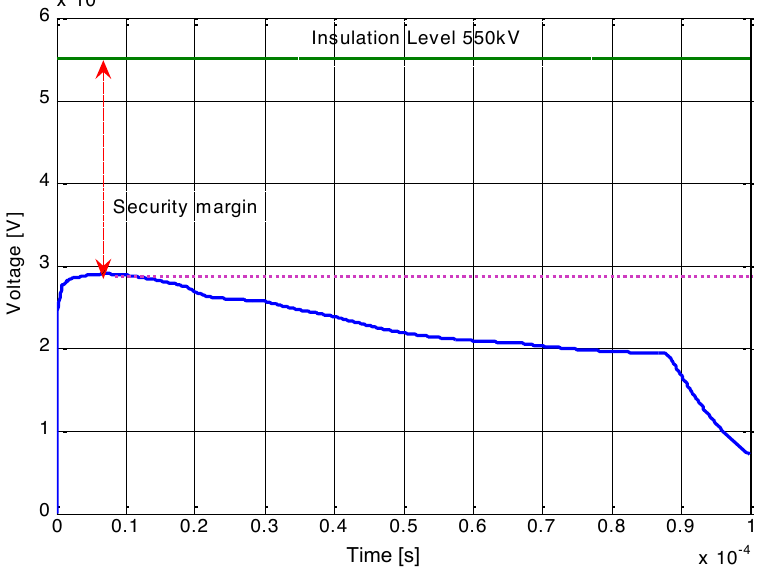
Fig. 6. Residual voltage for discharge current 10 kA with impulse form 8/20 µs/µs (U r = 280